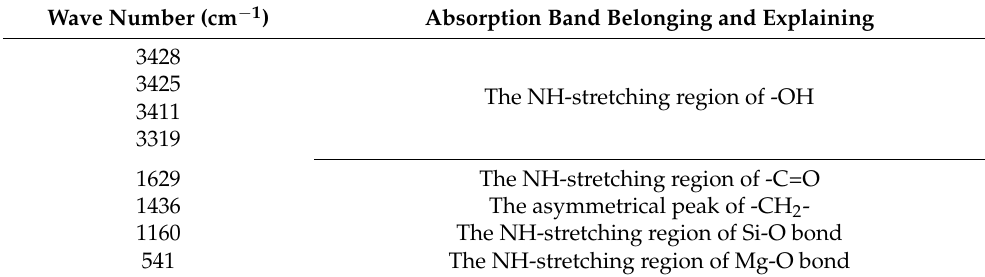
Figure 6. FTIR of MOPB modified by FA with different addition. FA addition: F 0 = 0 wt%, F 1 = 5 wt%, F 2 = 15 wt%, F 3 = 20 wt%, F 4 = 25 wt%, F 5 = 35 wt%. Table 6. Functional group of